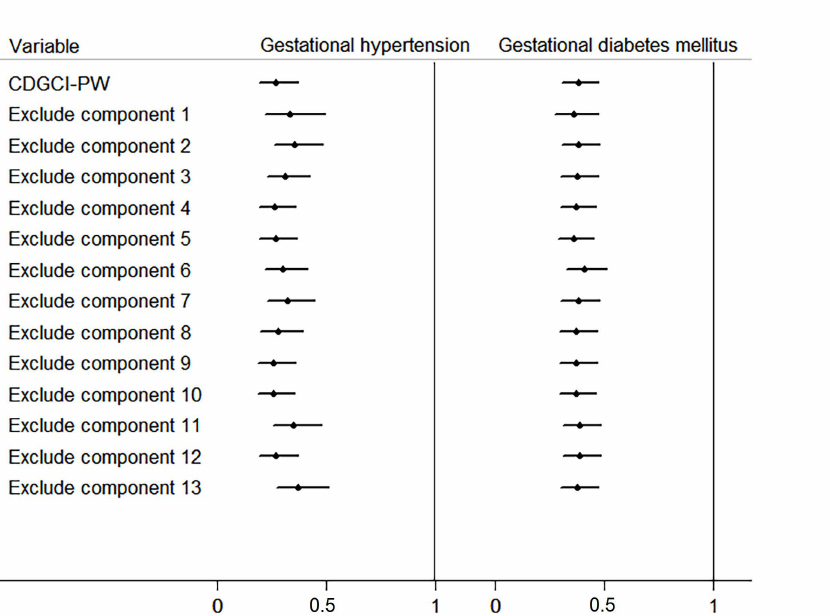
Figure 2. Association between maternal CDGCI–PW scores alternately excluding individual com- ponents and risks of pregnancy complications (per 10-point increment). Black dots for gestational hypertension and gestational diabetes mellitus denote logistic regression coefficients and horizontal lines denote 95% CIs. CDGCI–PW: Chinese dietary guidelines compliance index for pregnant women. Component 1, food categories per week on average. Component 2, food kinds per day on average. Components 3 through 12, the degree to which a person’s diet accords with the recommendations of the CDG-PW for nine major food groups: staple food (cereals and their products, potatoes, and beans other than soybeans), whole grains and beans other than soybeans, green leafy and colored vegetables (red and yellow), milk and its products, soybean and its products, nuts, lean meat (livestock and poultry meat), animal blood and liver, iodized table salt, and iodine-rich seafood. Component 13, eating